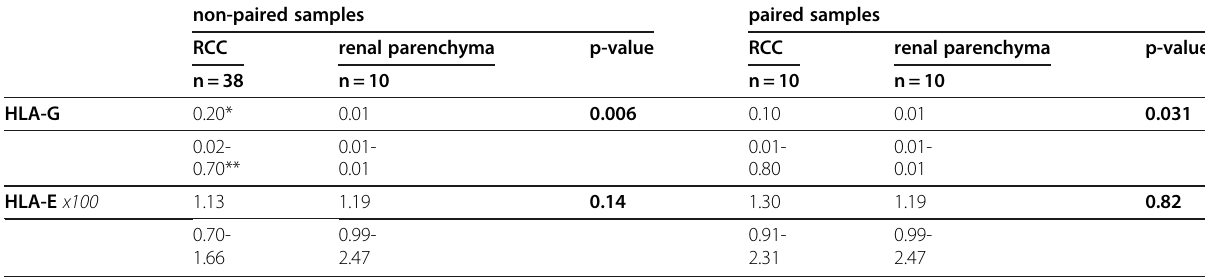
Table 2 Expression levels of HLA-G and HLA-E in RCC tissue in comparison to renal parenchyma non-paired